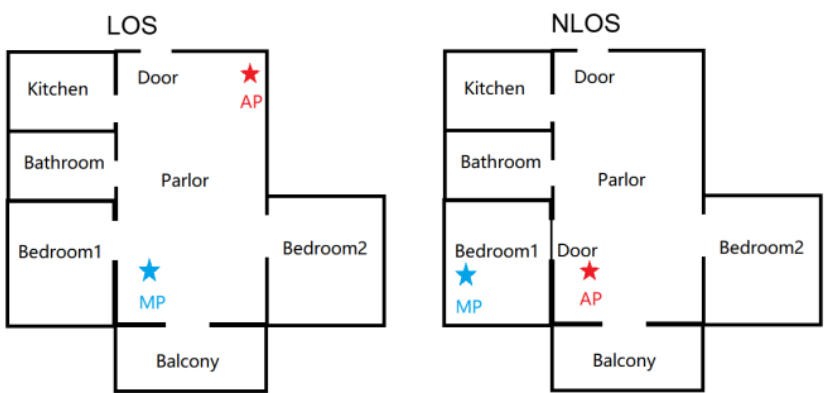
Figure 17. The layouts of selected apartments with different deployment of access point (AP) and monitor point (MP).